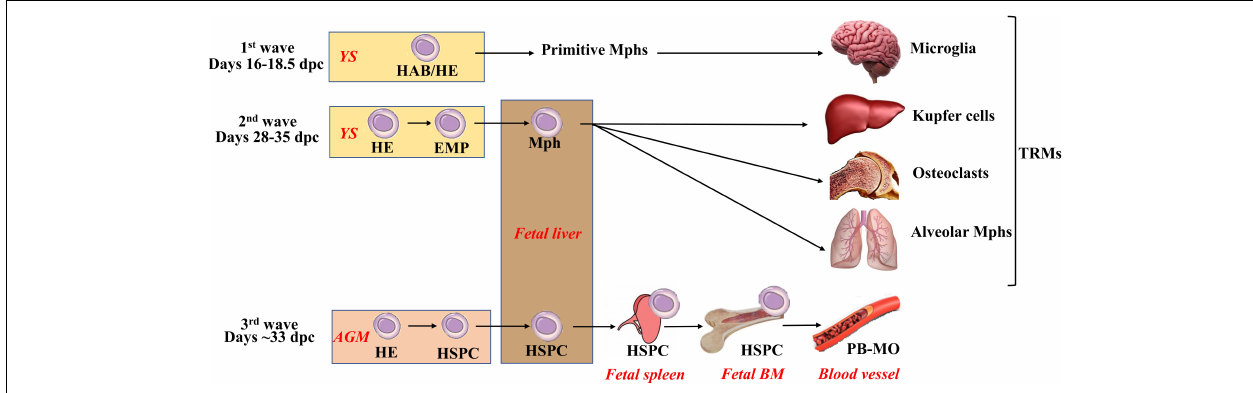
FIGURE 1 | Three waves of macrophage generation during embryonic hematopoiesis. Embryonic hematopoiesis occurs in at least three waves. The first wave (primitive hematopoiesis) takes place extraembryonically in the yolk sac. At this wave, primitive macrophages, erythrocytes, and megakaryocytes are generated. Their exact cellular source is not fully clear: it is suggested that this is HAB (i.e., a common precursor of hematopoietic and endothelial cells), but the emergence of primitive hematopoietic cells directly from mesoderm or HE (i.e., endothelial cells having a potential to generate blood cells) is also considered. Primitive macrophages migrate to the central nervous system to form primitive microglia, and they also give rise to Langerhans cells. During the second wave (early or the first definitive), HE is formed and generates EMPs that give rise to definitive erythrocytes, megakaryocytes, and myeloid cells. EMP-derived macrophages mature in the fetal liver, seed the tissues (other than brain), and form self-renewing TRM pools. The third (definitive) wave takes place primarily in the AGM (other involved sites include placenta, vitelline, and umbilical arteries). At this stage, HE gives rise to long-term repopulating HSPCs. HSPCs migrate to the fetal liver; self-renew; expand; home to the spleen, thymus, and fetal BM and initiate adult-type hematopoiesis. AGM, aorta-gonad mesonephros; HAB, hemangioblast; HE, hemogenic endothelium; HSPCs, hematopoietic stem and progenitor cells; EMP, erythromyeloid progenitors; PB-MO, peripheral blood monocytes.